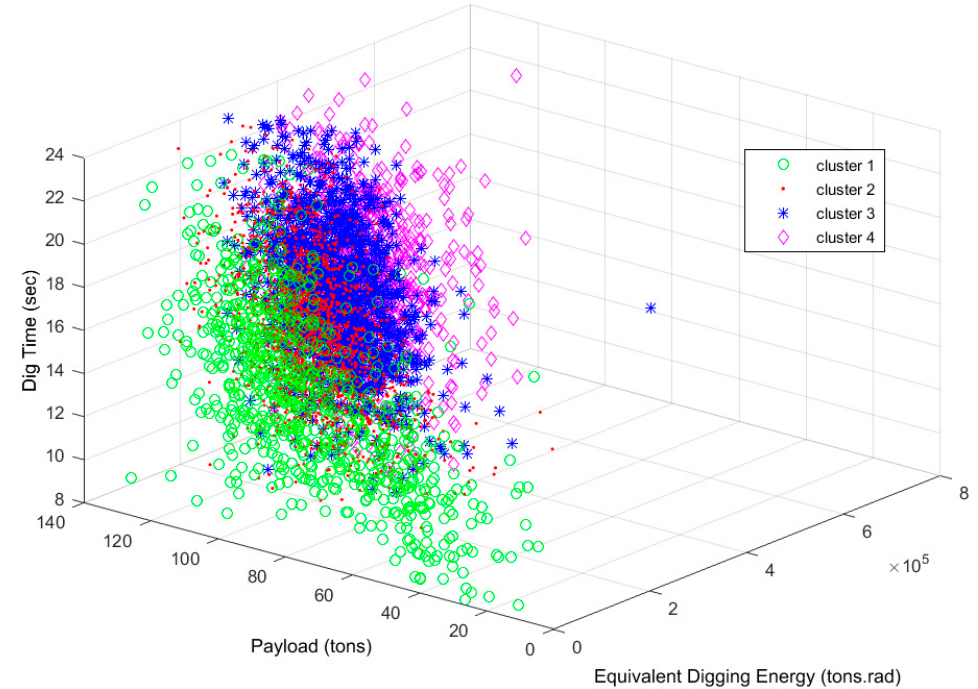
Figure 4. Generated clusters using K-means clustering method.